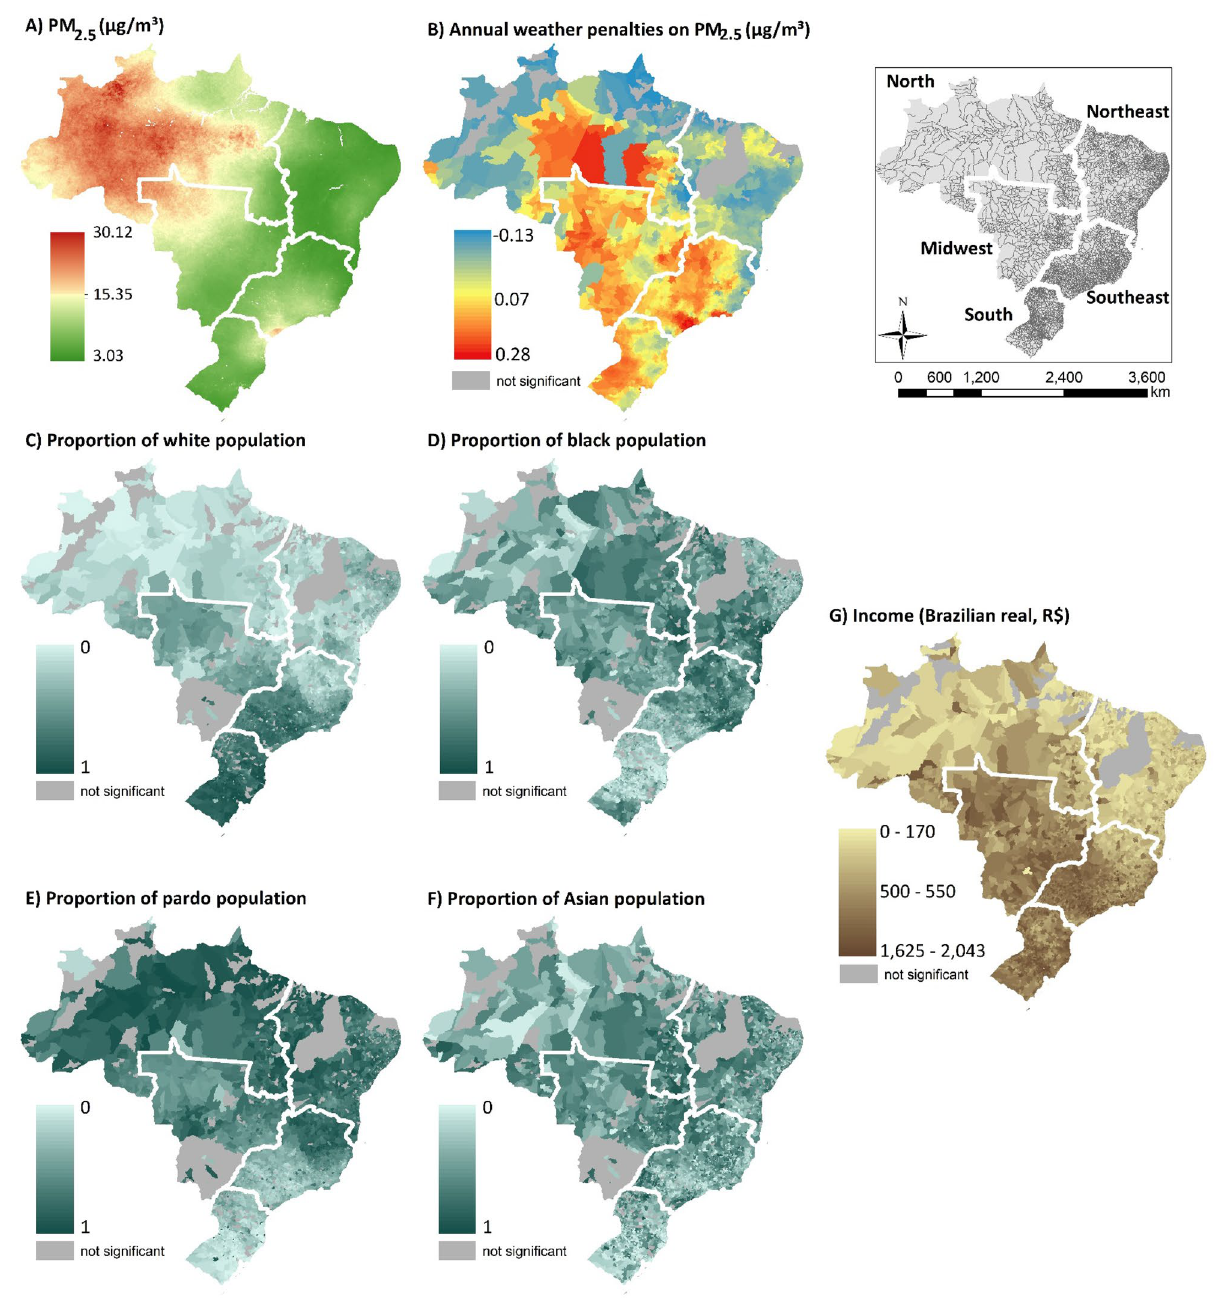
Figure 1. Spatial distribution of PM 2.5 concentration (spatial resolution of 1 × 1 km), annual weather penalties on PM 2.5 (by municipalities), population by race groups (population in the racial group/total population, by municipalities), and income (by municipalities). Note 1 : “not significant” represents the municipalities with non- significant penalties. Note 2 : the top right map shows Brazil’s regions and municipalities. Note 3 : This figure was created by R version 4.1.3. ’https:// www.r- proje ct.